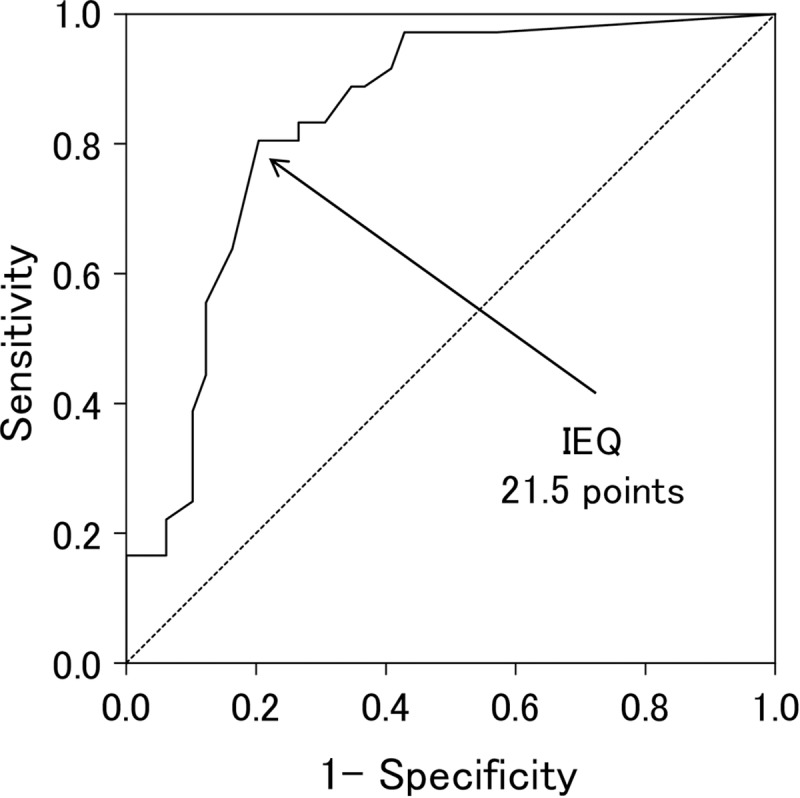
Receiver operating characteristic (ROC) curves of the IEQ scores for a prolonged number of days until insurance claim closure.The optimal cutoff point of the IEQ scores for a prolonged number of days until insurance claim closure was 21 and 22 points, respectively. IEQ, Injustice Experience Questionnaire. *Significance level was set at p < 0.05.